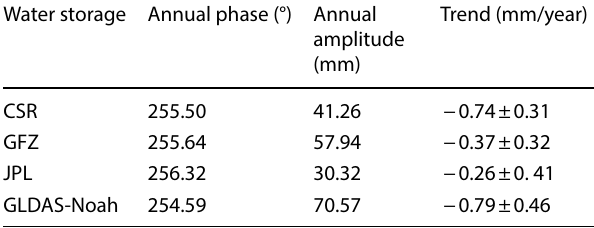
Table 1 Mean yearly phase, amplitude, and trend changes in GB computed by GRACE (CSR, GFZ, and JPL) and GALDAS-Noah mod- els Water storage Annual phase (°) Annual